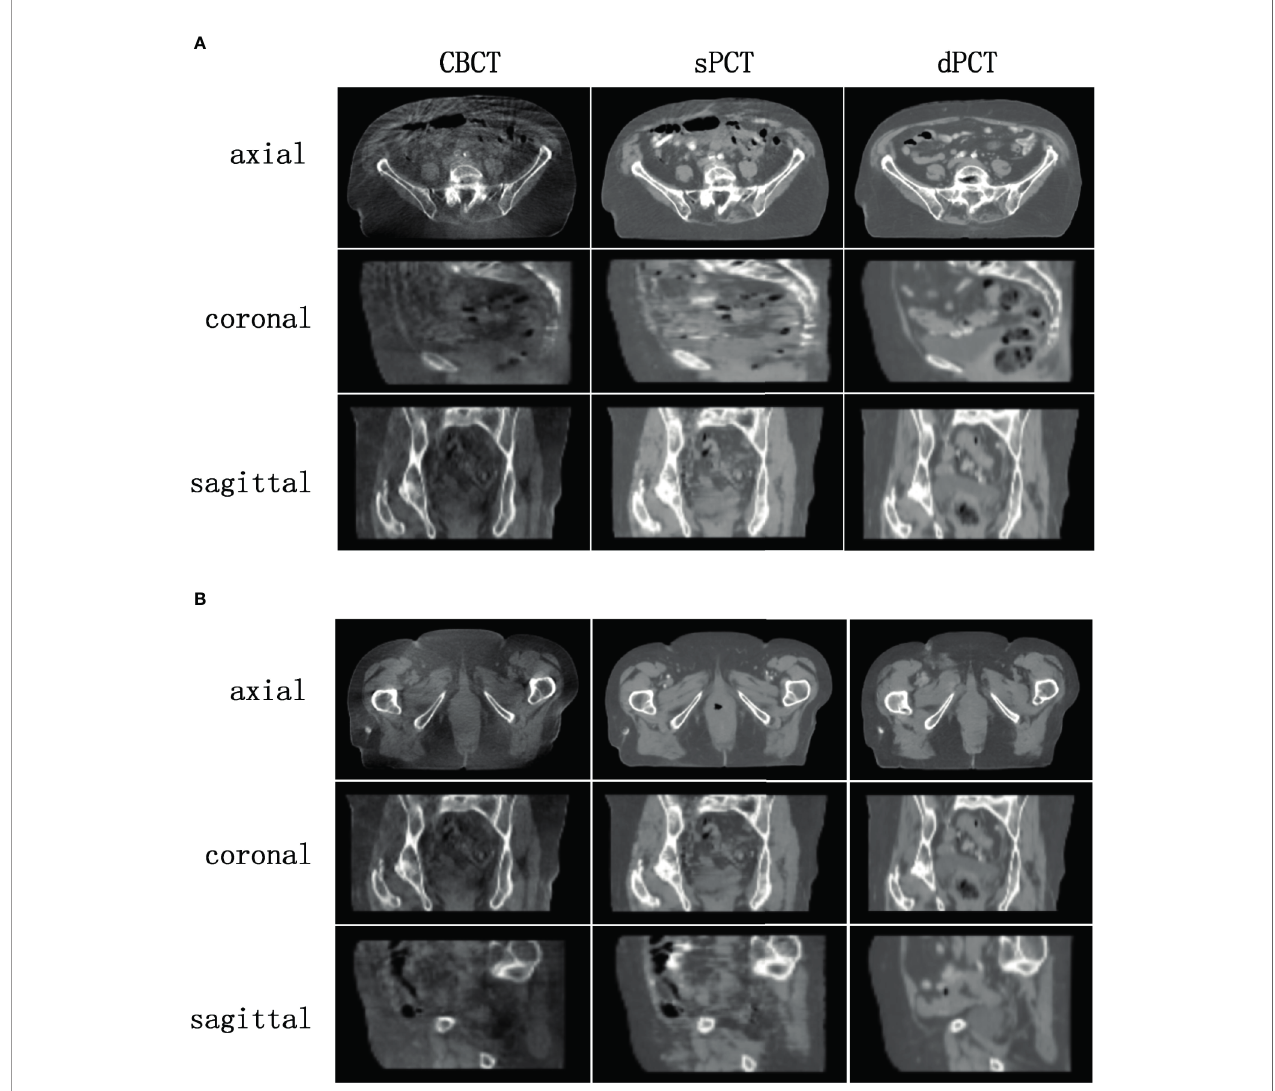
FIGURE 4 | Comparison of image quality among CBCT, sPCT, and dPCT of two patients (A, B) . For each patient, the images in the top, middle, and bottom rows are axial, coronal, and sagittal, respectively. The left, middle, and right images represent CBCT, sPCT, and dPCT respectively. The display window is (700, 1300)